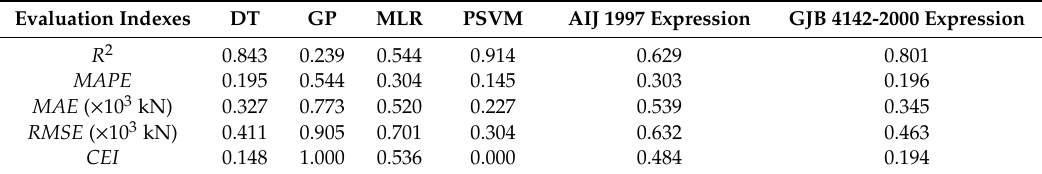
Table 3. Prediction performance evaluation of DT, GP, MLR, PSVM, AIJ 1997, and GJB 4142-2000 expressions in the test